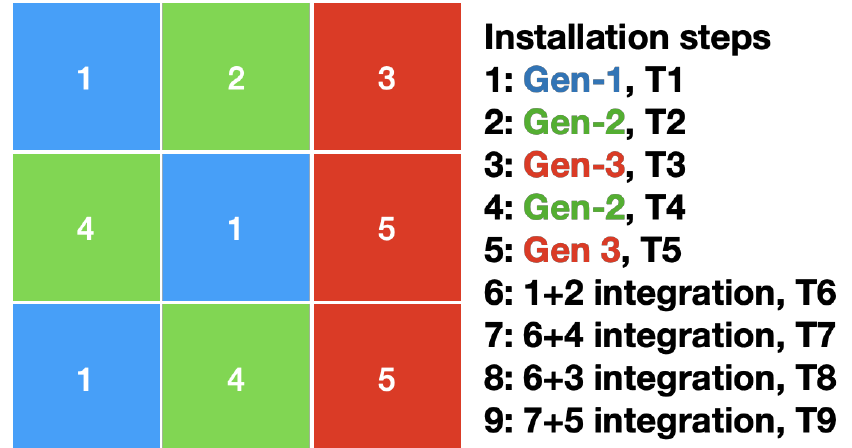
Figure 2. Smart streetlight installation plan for different sections in the city. The smart streetlights generation, section installation time, and section-to-section integration time is indicated for each city